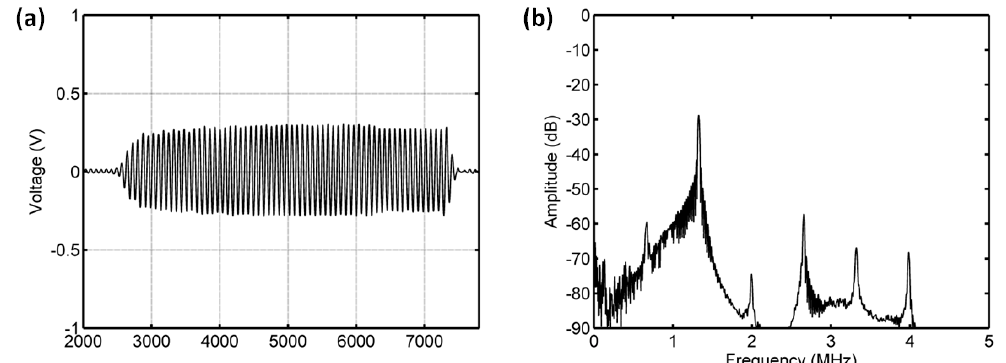
Figure 18. The measured scattering signals from microbubbles and the averaged power spectrum of 50 received signals. ( a ) A single received signal, ( b ) the averaged power spectrum. The driving frequency was 1.33 MHz, the acoustic pressure was 350 kPa, and the overpressure was 180 mmHg.